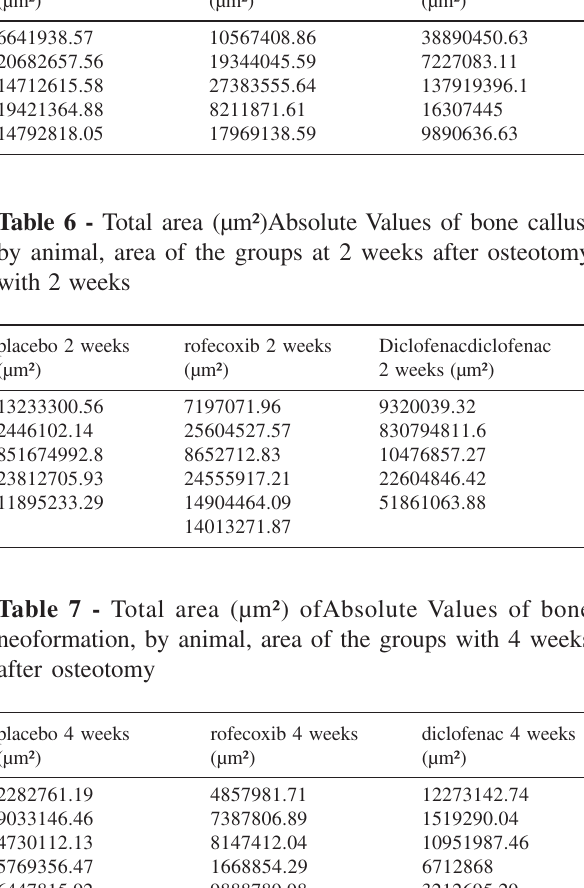
Table 5 - Absolute ValuesTotal area (µm²) of bone callus, by animal, area of the groups awith t 4 weeks after osteotomy placebo 4 weeks